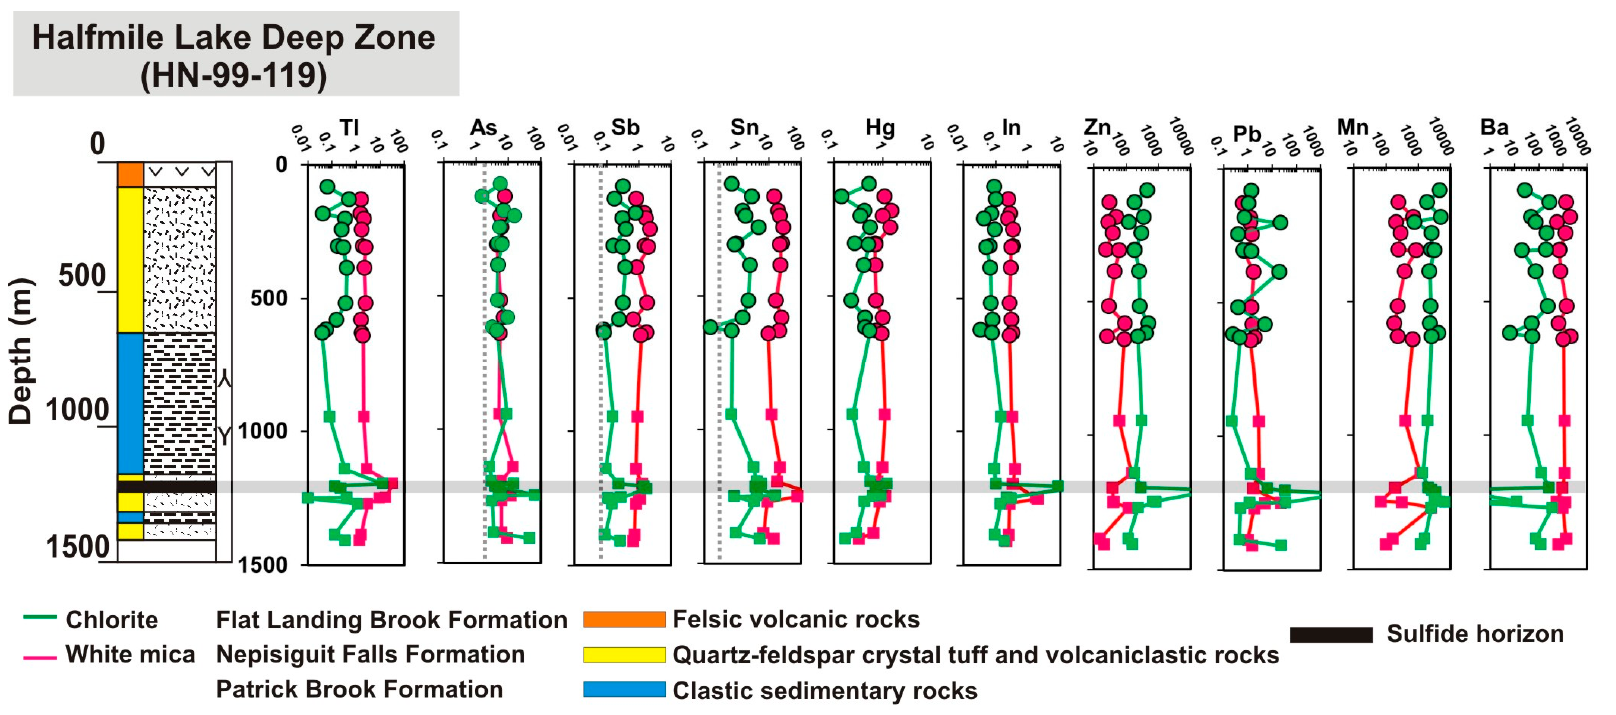
Figure 11. LA-ICP-MS geochemical data profiles illustrating fluid-mobile elements, as well as Zn, Pb, Mn, and Ba content (in ppm) of chlorite and white mica plotted with respect to the stratigraphy of the Halfmile Lake Deep zone deposit intersected by drill hole HN-99-119 (see Supplementary Tables S6 and S7). Black outlined symbols denote hanging wall samples.